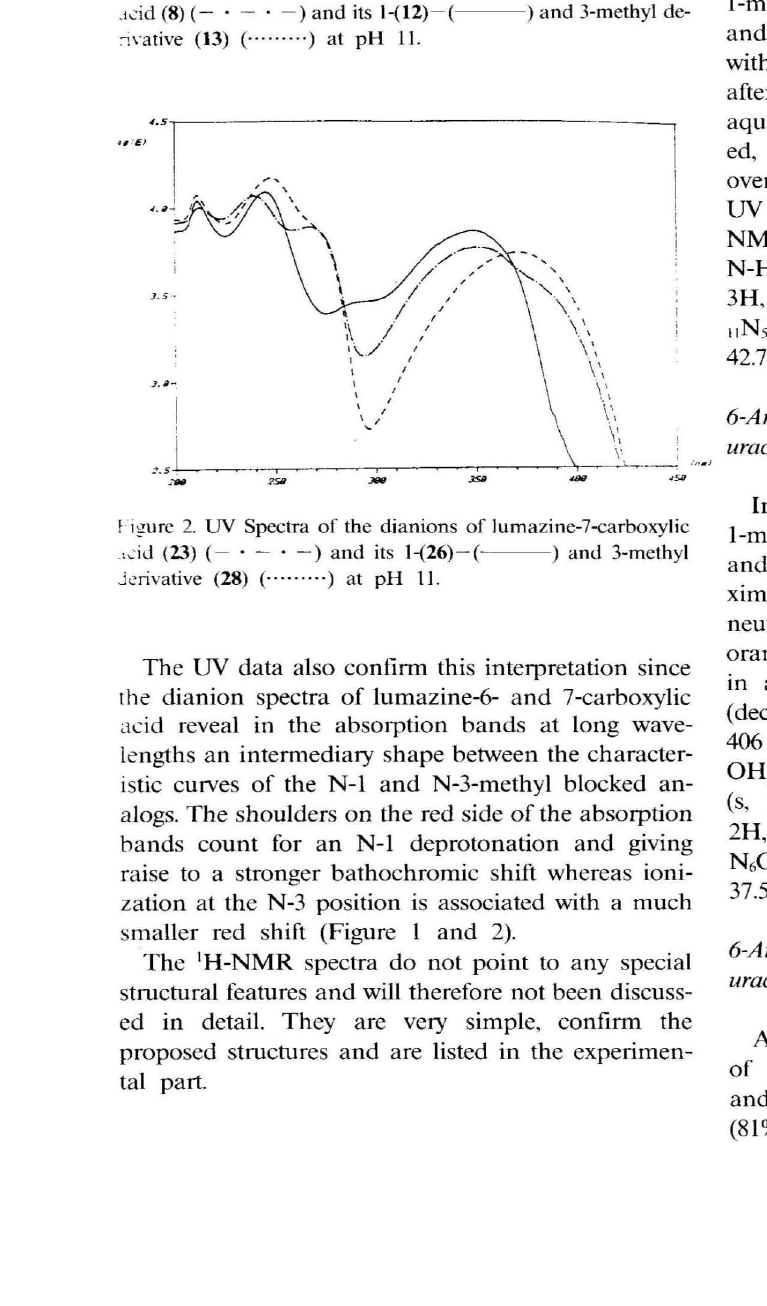
Figure I. UV Spectra of the dianions of lumazine-6-carboxylic .h:id (8)( - . - . -) and its 1-(12)-(-- ) and 3-methyl de-